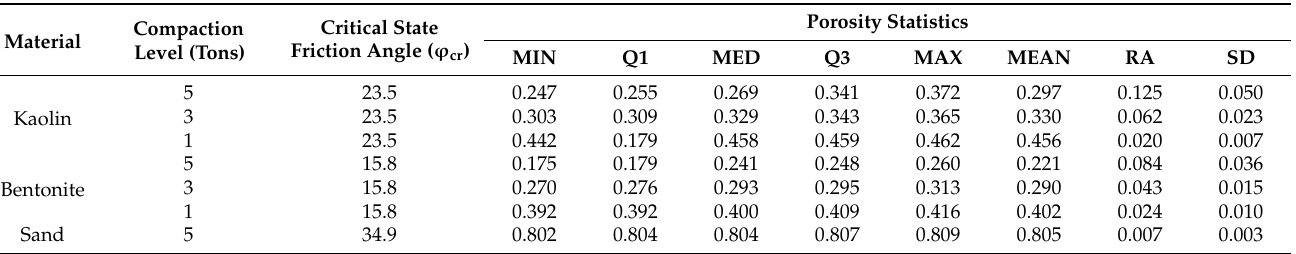
Table 1. Porosity number statistics of the samples. Data on critical state friction angle (see also Table S2) are included for comparison.